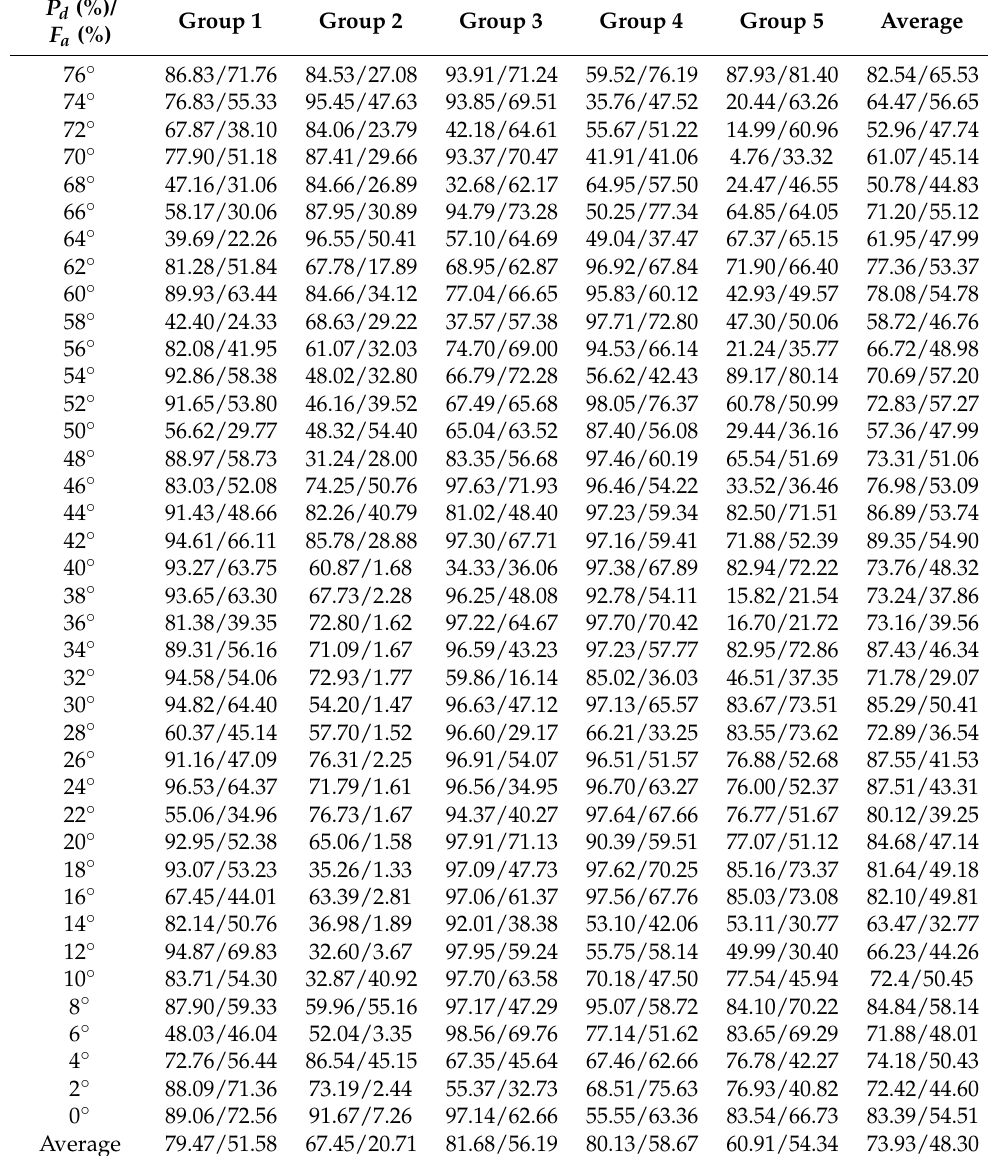
Table 6. Probability and false alarm rate of segmentation results obtained by Method 2.